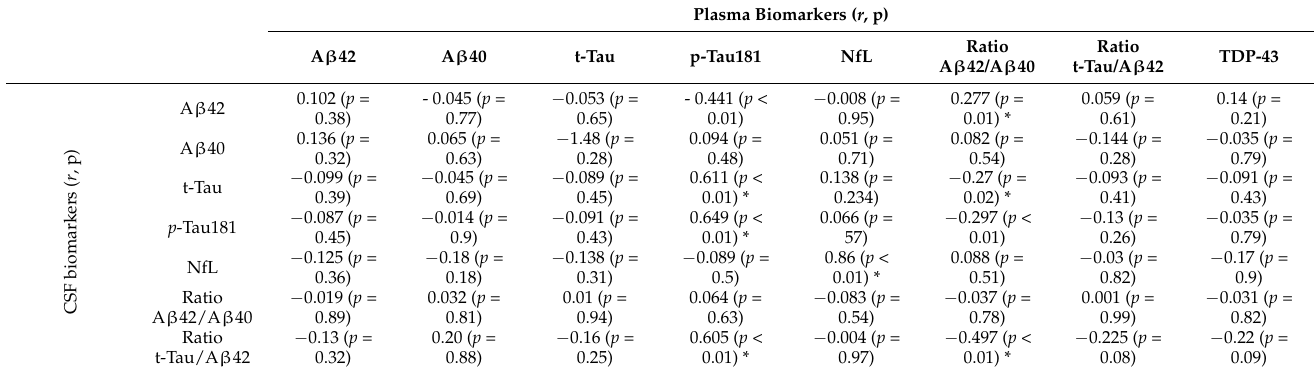
Table 2. Pearson’s correlations between CSF and plasma